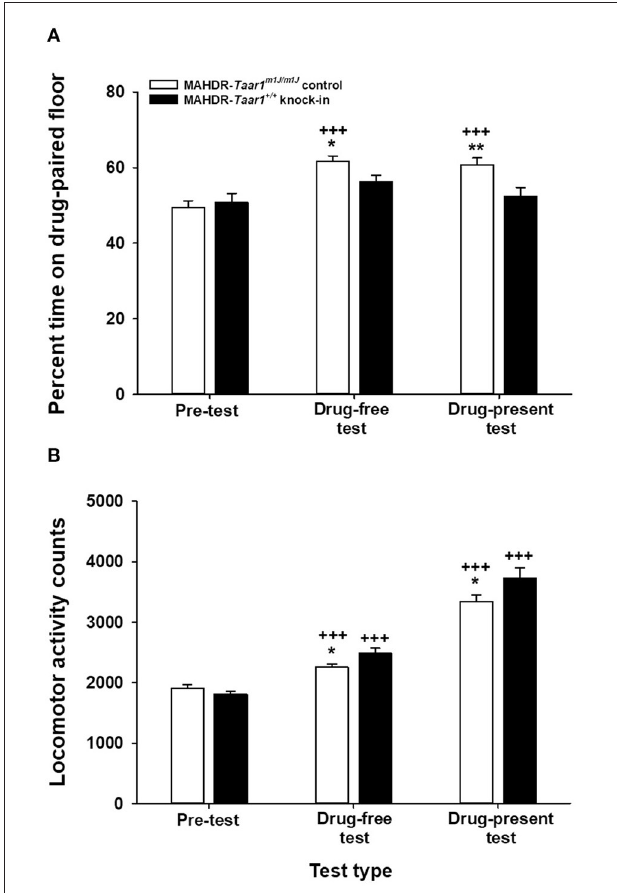
FIGURE 2 | MAHDR- Taar1 m 1 J / m 1 J control mice, but not MAHDR- Taar1 + / + KI mice, exhibit MA-induced conditioned place preference and are less active during preference testing. Shown are means ± SEM for (A) percent time on drug-paired floor during the pre-test, drug-free test, and drug-present test and for (B) locomotor activity counts during the three tests. Mice were treated with saline prior to preference testing for the pre-test and drug-free test, and with 0.5 mg/kg MA prior to the drug-present test; tests were 30min in duration. Total N = 96 mice (12 mice per line per sex were conditioned with MA on the grid floor; 12 mice per line per sex were conditioned with MA on the hole floor). * p ≤ 0.05, ** p < 0.01 for the line difference; +++ p < 0.001 for the difference from pre-test in (A) and for the difference from pre-test and drug-free or drug-present test in (B) . MA, methamphetamine; MAHDR, methamphetamine high drinking mice; Taar1 + / + , homozygous reference trace amine-associated receptor 1 genotype; Taar1 m 1 J / m 1 J , homozygous mutant